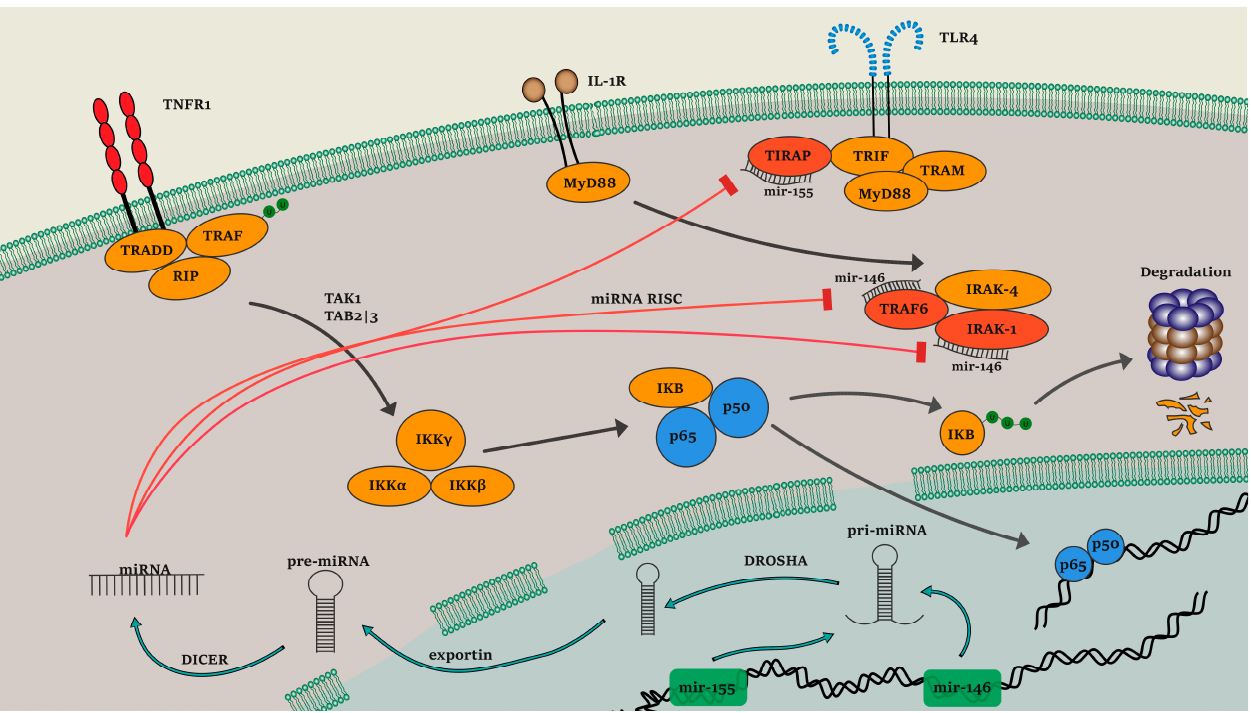
Figure 1. Expression of mir-146a and mir-155 and their implication in the NF- κ B pathway.